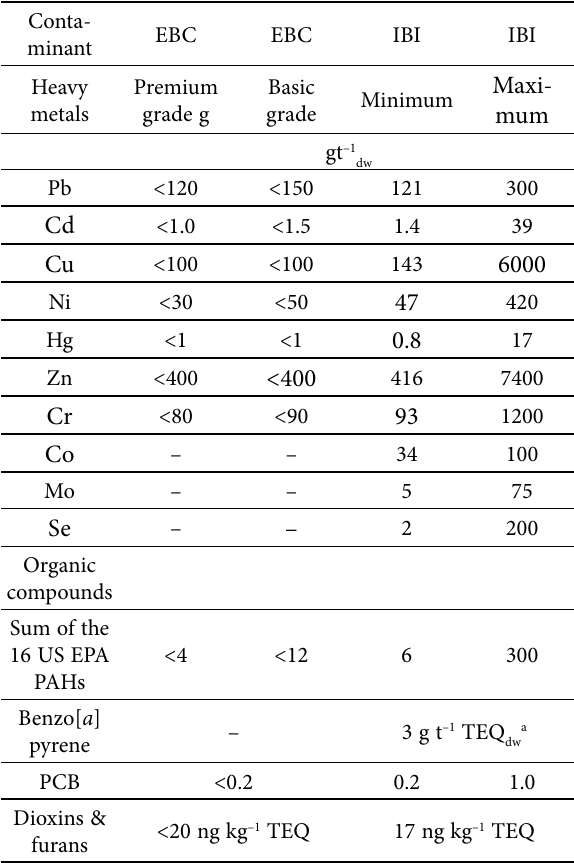
Table 1. List of inorganic and organic thresholds of contaminants recommended in biochars of the European Biochar Certificate (EBC 2012) and the International